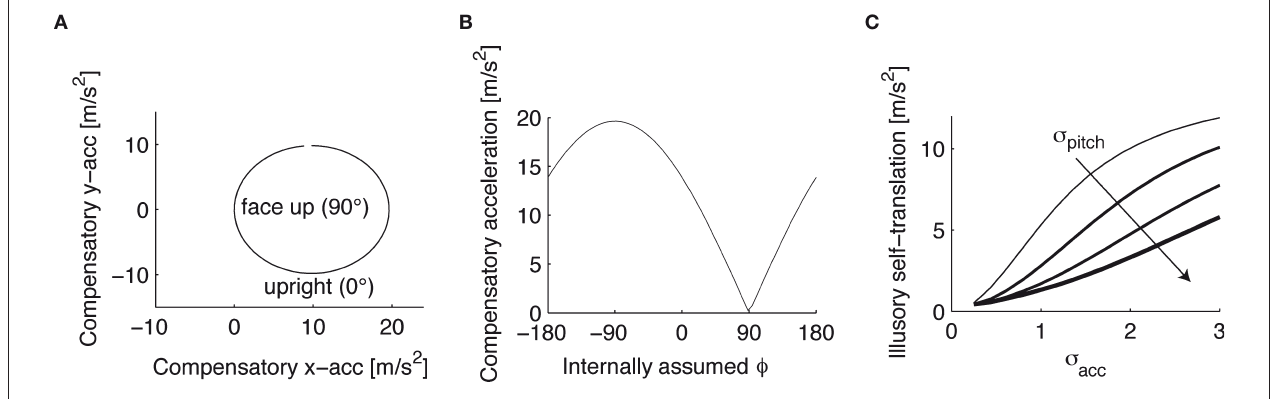
compensatory acceleration as a function of the internally assumed pitch rotation. If the actual supine position, 90 ° , and the internally assumed position coincide, no compensatory acceleration is necessary. (C) Dependence of the compensatory acceleration on the variance of the acceleration and pitch